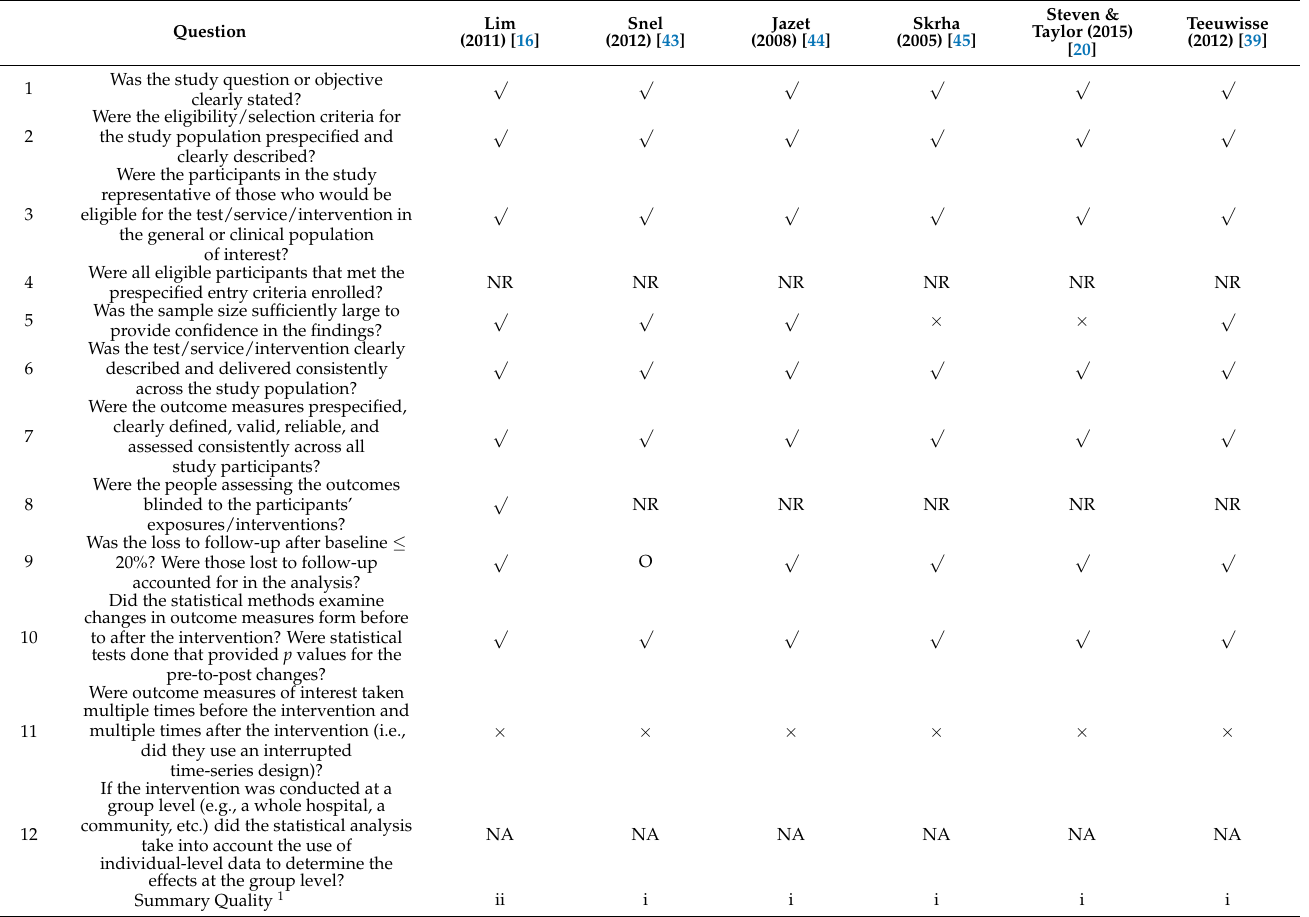
Figure 3. Risk of bias presented using Cochrane ROBINS-I tool for the non-randomized control trial [42]. Table 1. Risk of bias presented using the NIH Quality Assessment Tool for non-randomized trials (i.e., before-after studies, non-randomized pilot study, and single arm intervention